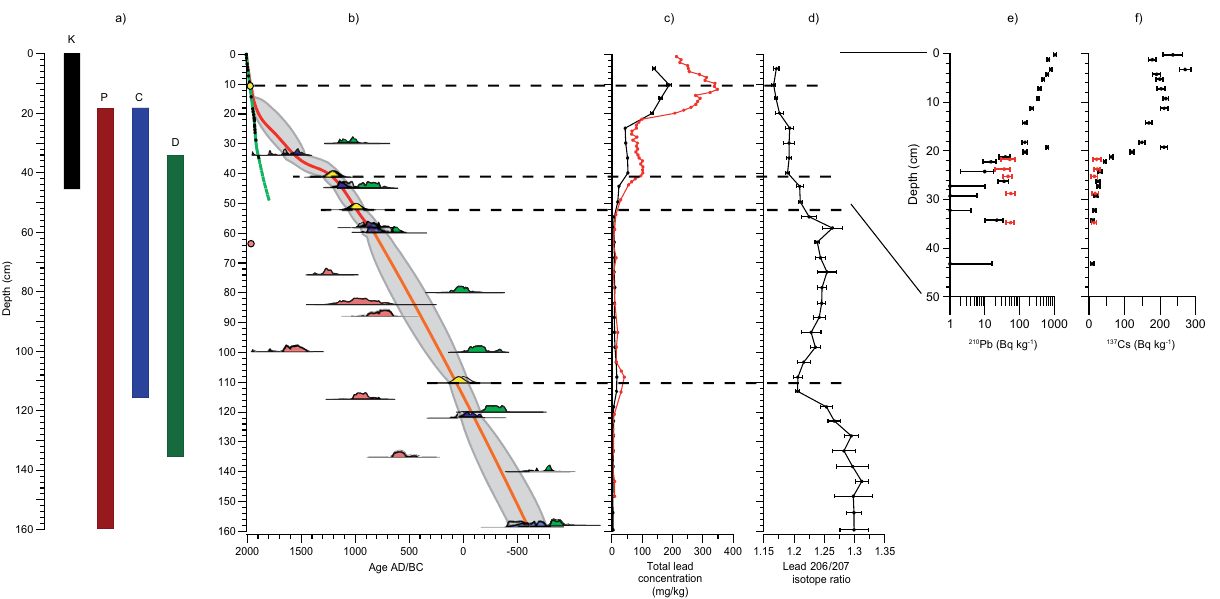
Fig. 2. (a) Cores used in this study. (b) Age model established by the OxCal program when including six radiocarbon dates based on three large ( > 2mg) macrofossils (dark blue) and three small ( < 2 mg) macrofossils (light blue), a CRS-model based on nine 210 Pb samples (black dots above 15cm), and four lead pollution markers (yellow, Br¨annvall et al., 2001). Seven radiocarbon dates based on small macrofossils (red), eight bulk radiocarbon dates (green) and all 210 Pb samples below 15cm were excluded when constructing the model. Two polynomial functions, one above (red line) and one below 60cm (orange line), with a polynomial order of seven and two, respectively, were fitted to the midpoints of the calibrated 2 σ intervals (grey) provided by OxCal and used to calculate ages for the sequence at 0.5cm intervals. Green line represents the age/depth model used in Fredh et al. (2012). (c) Total lead concentrations measured using Quadrapole ICP-MS (black line) and XRF (red line), respectively. (d) Lead 206/207 ratio. (e, f) Unsupported 210 Pb and 137 Cs concentrations measured on core K (black) and core P